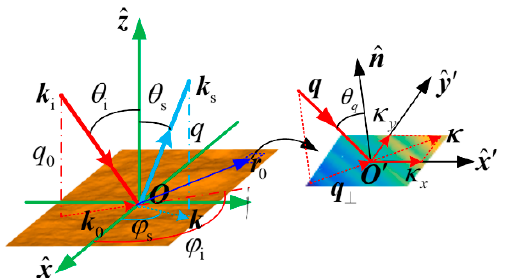
Figure 2. Comparison of NRCS results between the proposed method and the original SSA-II method under bistatic configuration in the near specular regime.